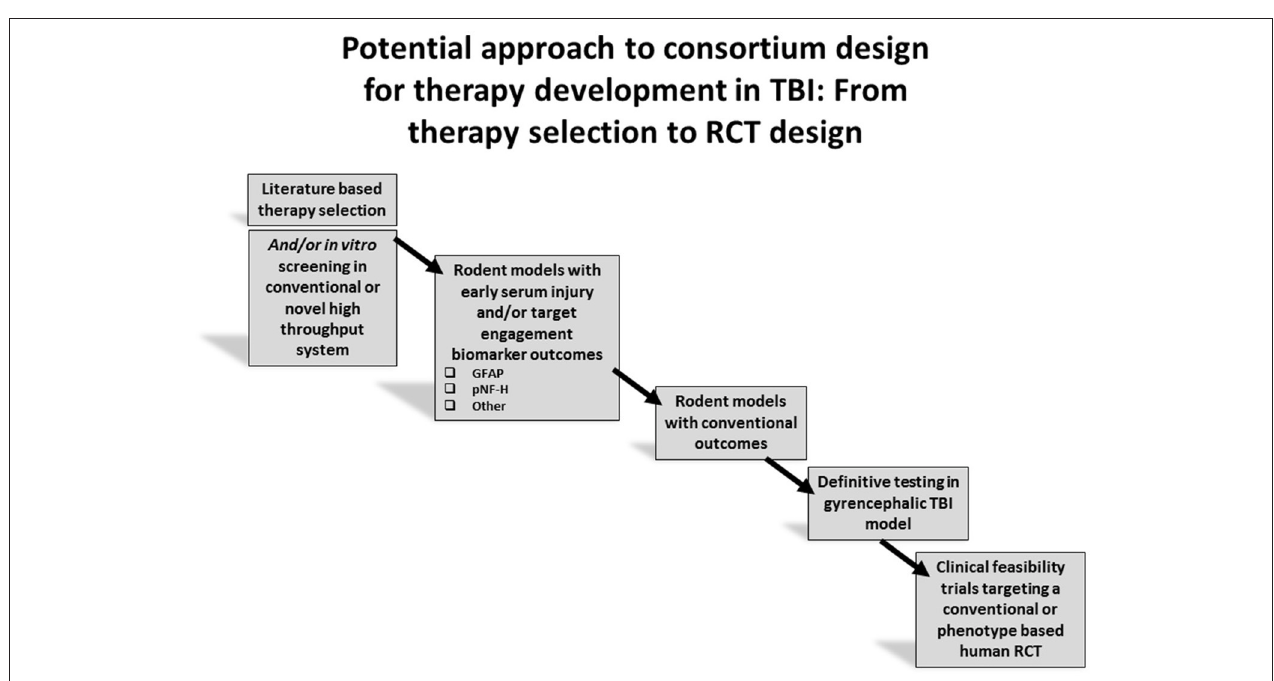
FIGURE 3 | Overall strategy for therapy development using target engagement biomarkers to aid in screening prior to advancing to definitive studies of long term outcome.